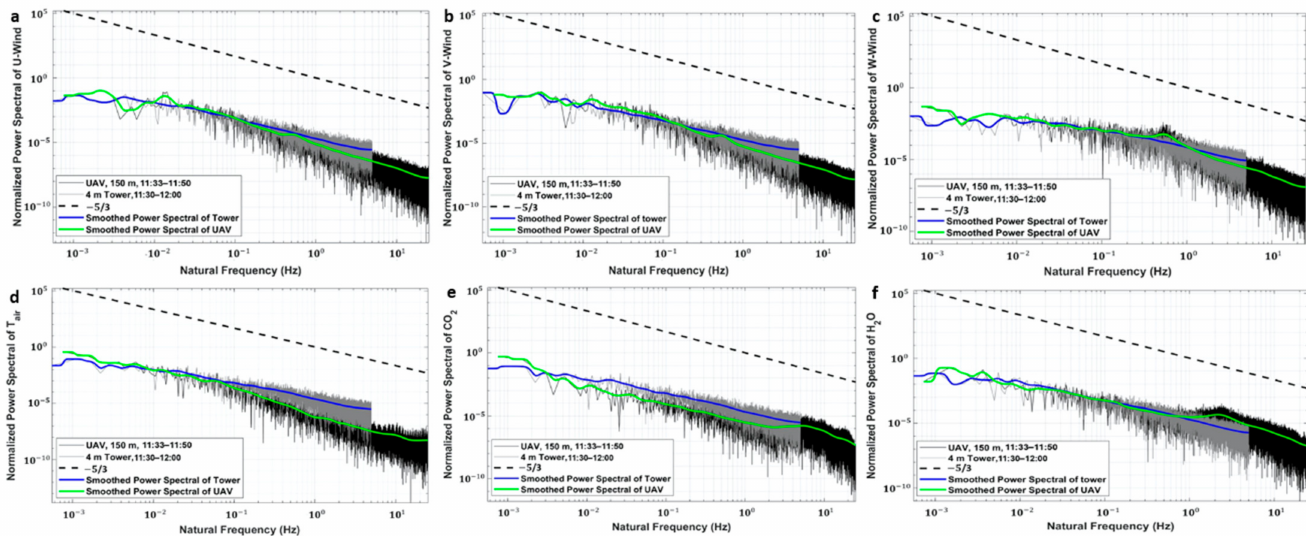
Figure 11. Normalized power spectra of the time series of the measured 3-D wind components in north direction ( a ), east direction ( b ), and upward direction, ( c ) as well as air temperature ( d ), carbon dioxide ( e ) and water vapor ( f ) on 23 October 2020, from the ground tower and